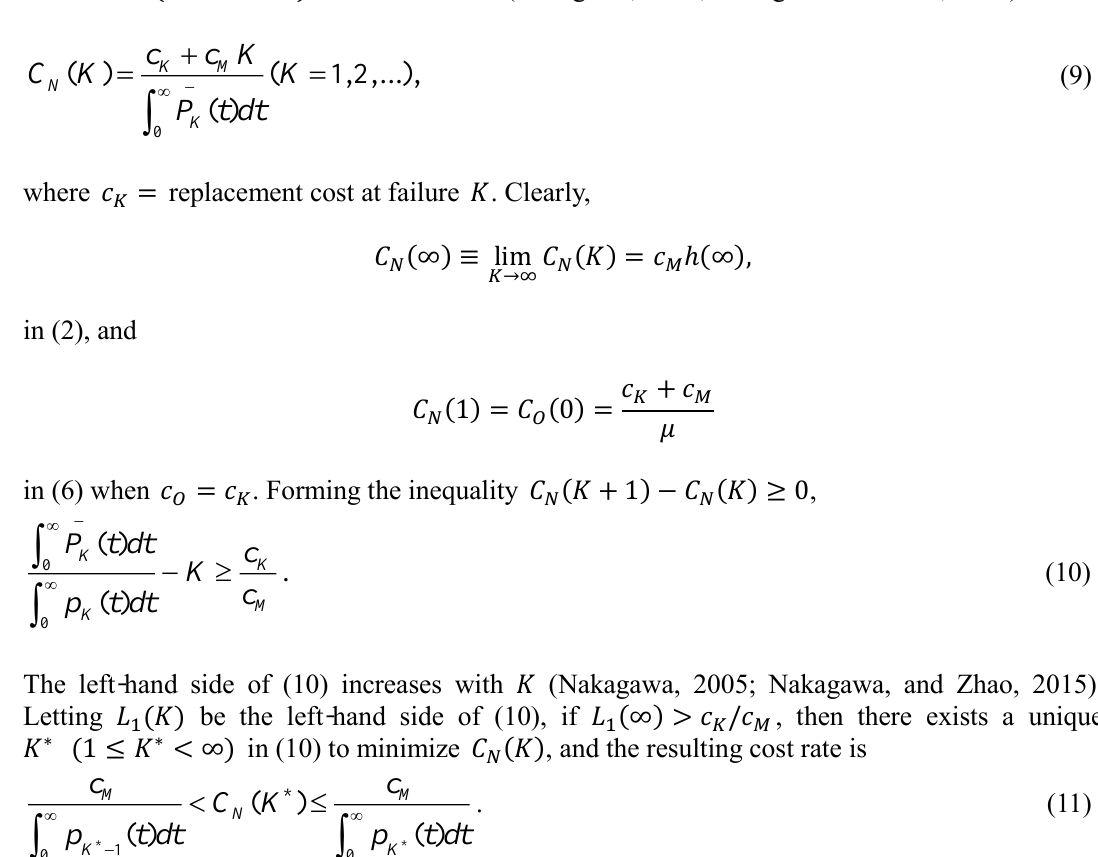
Table 3. Optimum 𝐾 ∗ and its cost rate when 𝐻(𝑡) = 𝑡 𝑚